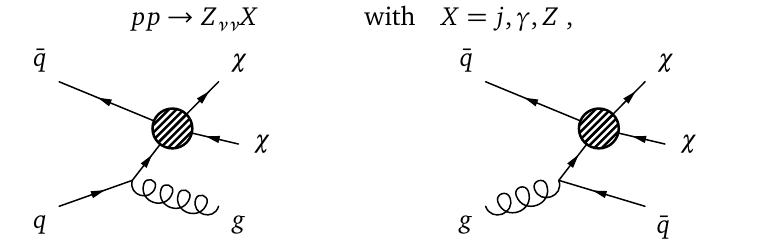
Figure 3: Feynman diagrams contributing to mono-jet